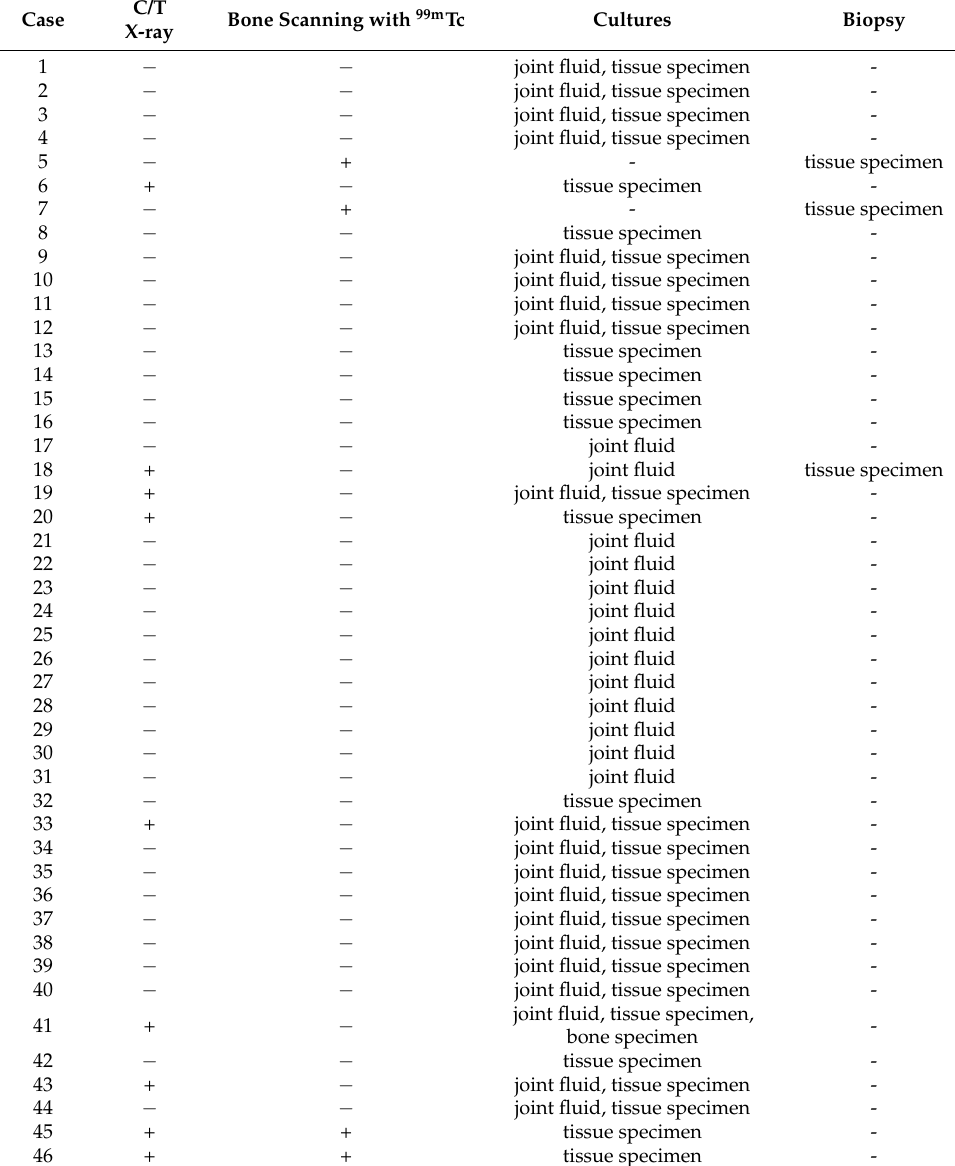
Table 2. Definite diagnosis of periprosthetic joint infections caused by fungus and imaging techniques that each case underwent during the process of diagnosing the infection, CT: computer tomography. (+): indicating that the method was used for diagnosis of the infection, ( − ): indicating that the method was not used for diagnosis of the